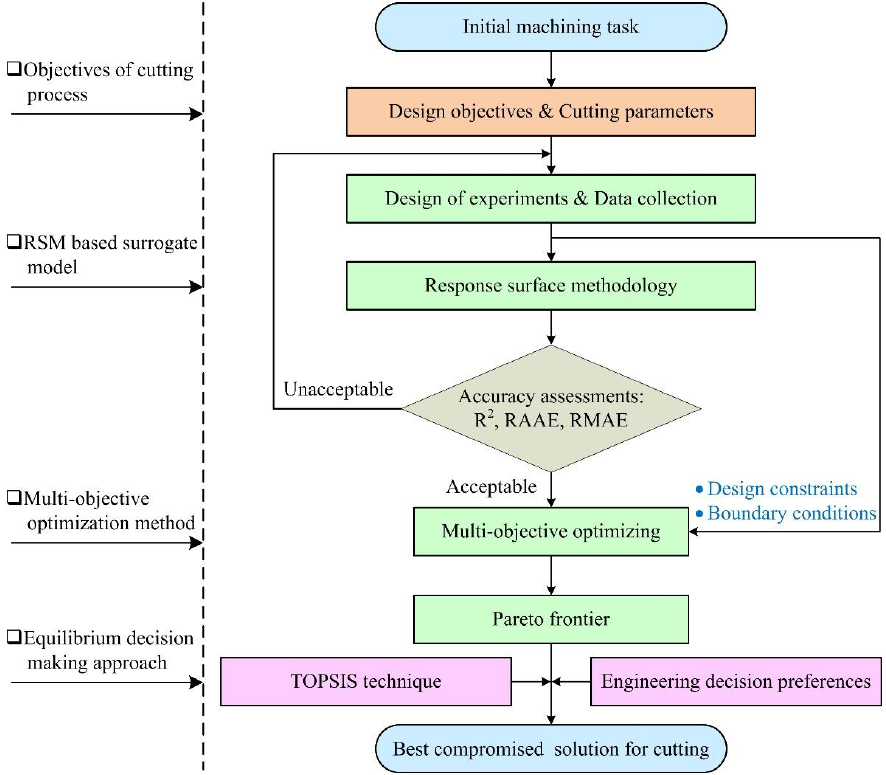
Figure 2. Flowchart of the equilibrium decision-making approach.